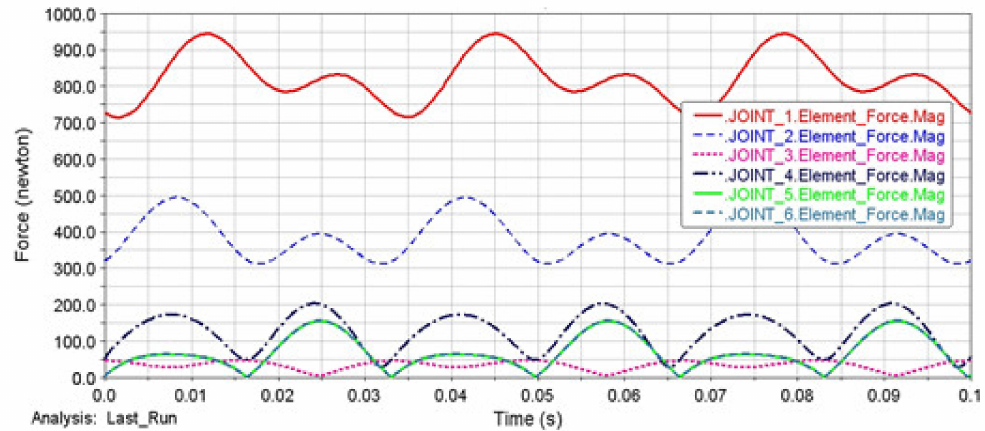
Figure 9. The performance of the dynamic forces in the joints of the mechanism at the deviation of the eccentric system e = 2 mm and frequency of 30